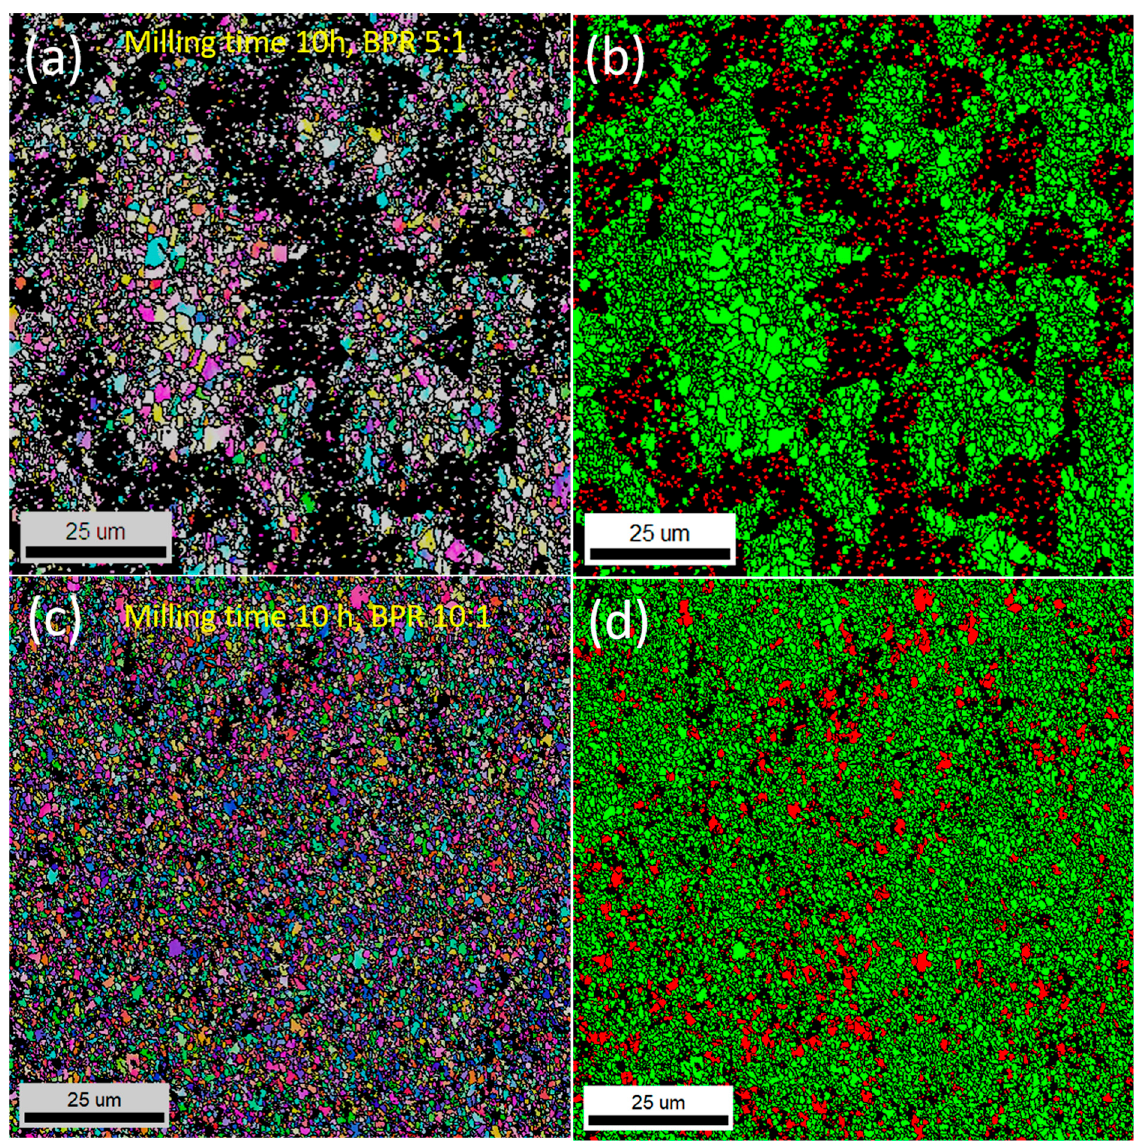
Figure 7. EBSD analyses on FeMn 30 Cu 5 hot-forged biodegradable alloys processed at different milling conditions: ( a ) colored map of 10 h and BPR 5:1 sample; ( b ) phase contrast map corresponding to ( a ); ( c ) colored map of 10 h and BPR 10:1 sample; ( d ) phase contrast map corresponding to ( c ); Here in phase contrast map of ( b , d ), green represent FCC-austenite, and red represent BCC-ferrite phases.